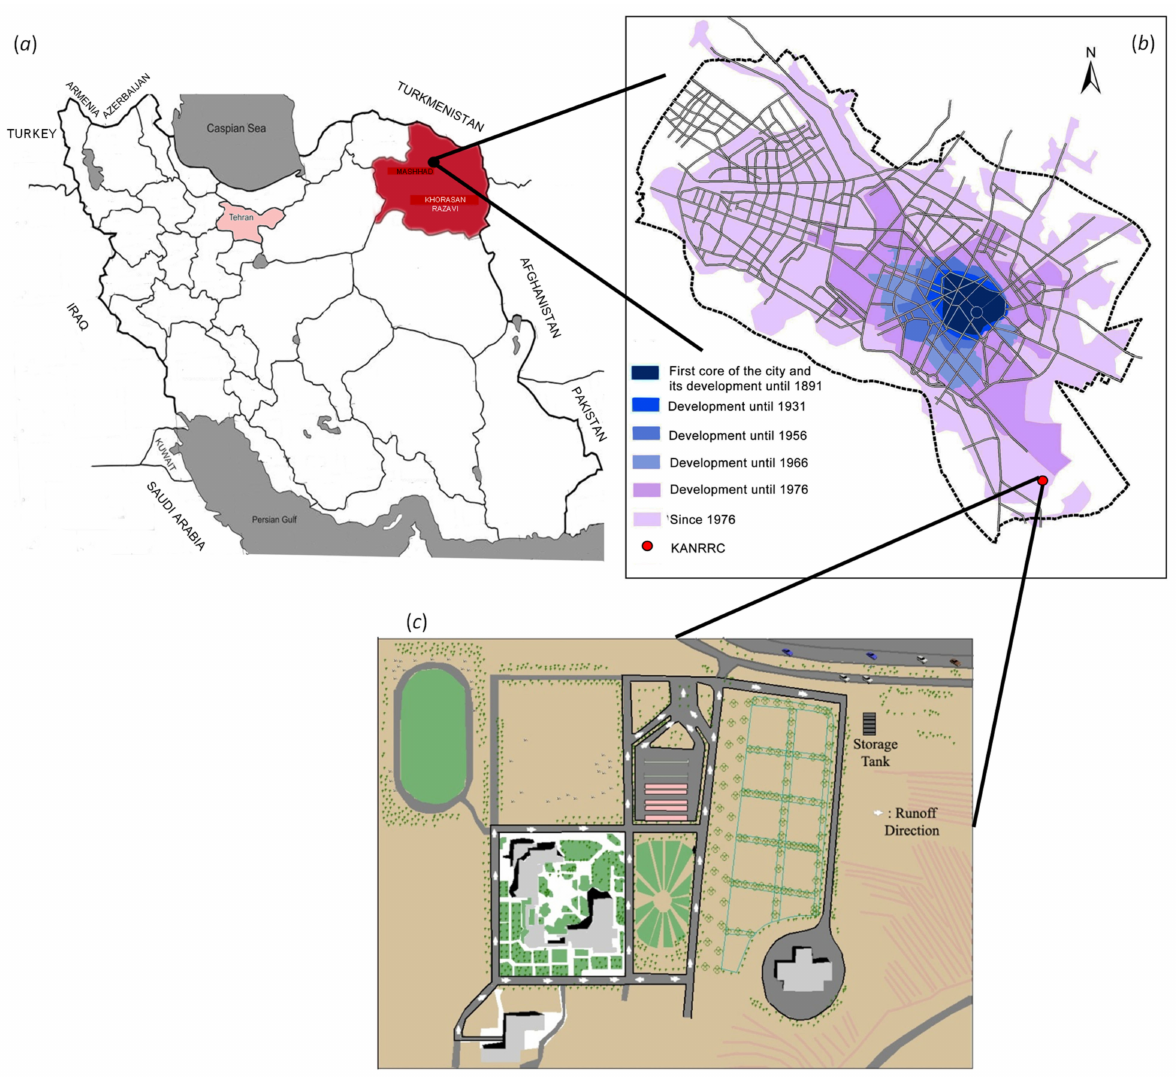
Figure 2. ( a ) Location of Mashhad city in Iran, ( b ) urban structure and development of Mashhad city since 1890s, and ( c ) schematics of the pilot RWH catchment and runoff direction across urban surfaces to the storage